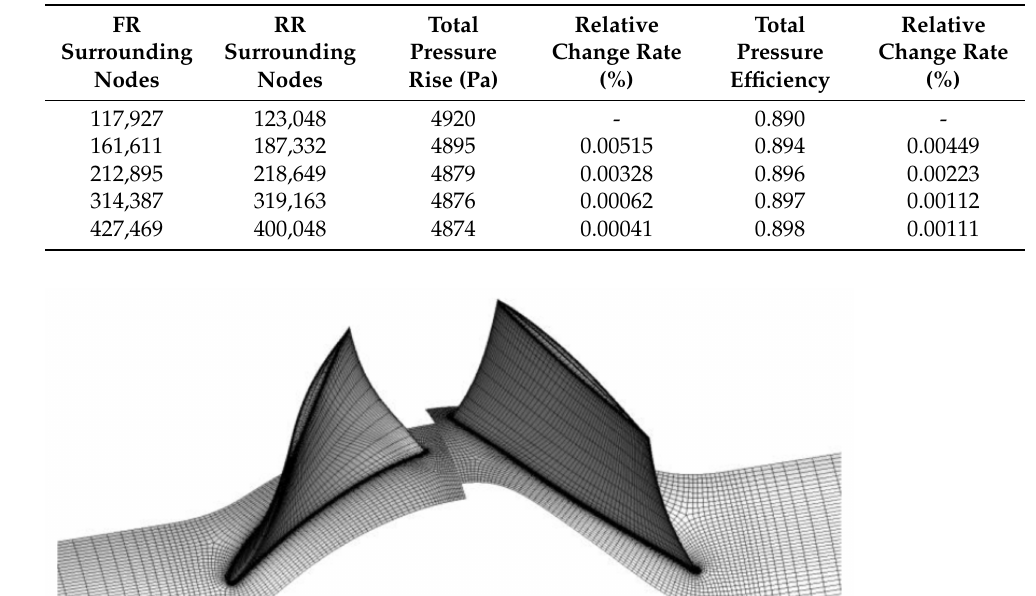
Table 4. Grid sensitivity analysis for the baseline CRF.